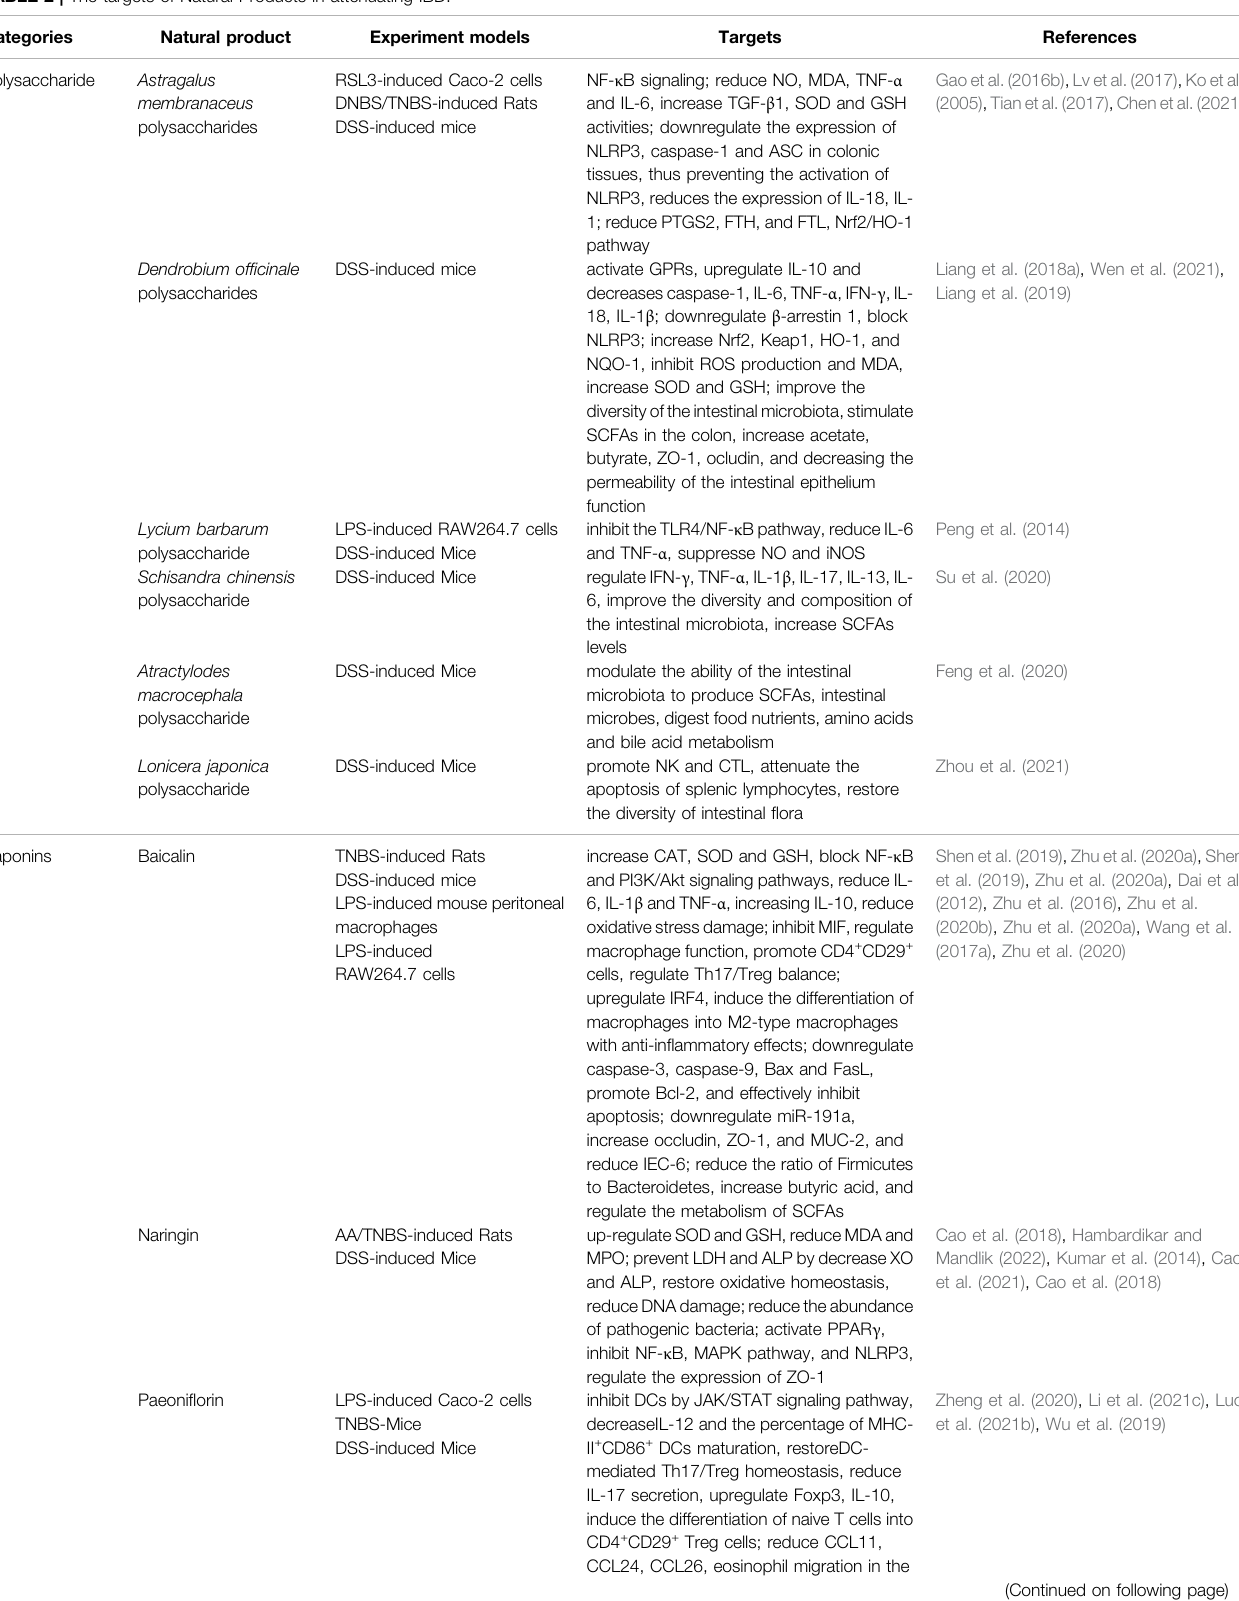
TABLE 2 | The targets of Natural Products in attenuating